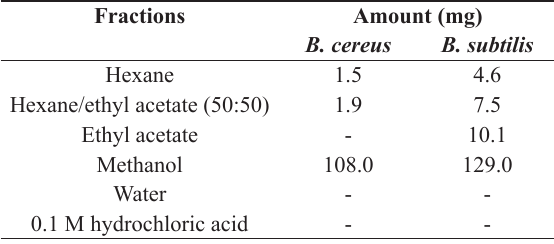
Fractions of dichloromethane-soluble metabolites produced by Bacillus cereus and B. subtilis , obtained after elution through a silica gel column.